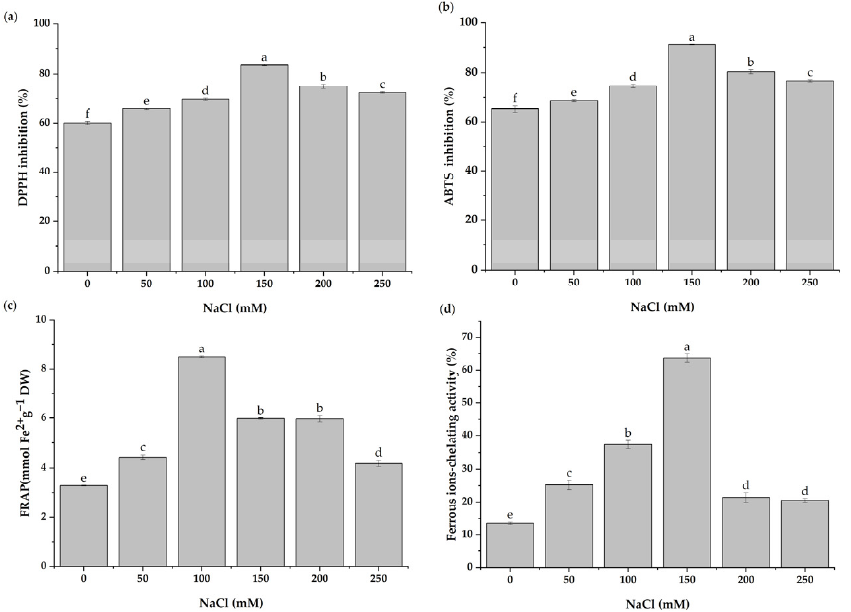
Figure 6. Changes in ( a ) DPPH inhibition, ( b ) ABTS inhibition, ( c ) ferrous-ion-chelating activity, and ( d ) FRAP antioxidant capacity levels in H. cannabinus leaves under different salt concentrations (0, 50, 100, 150, 200, and 250 mM of NaCl). The values presented are means ± SD ( n = 3). Different letters (a–f) above the bars indicate a significant difference between treatments according to the Duncan test ( p < 0.05).